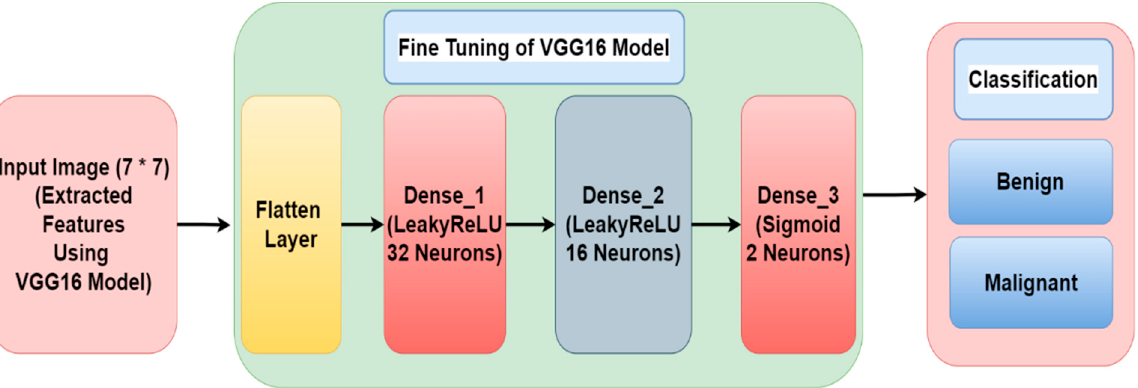
Figure 5. Fine Tuning of VGG16 Model.